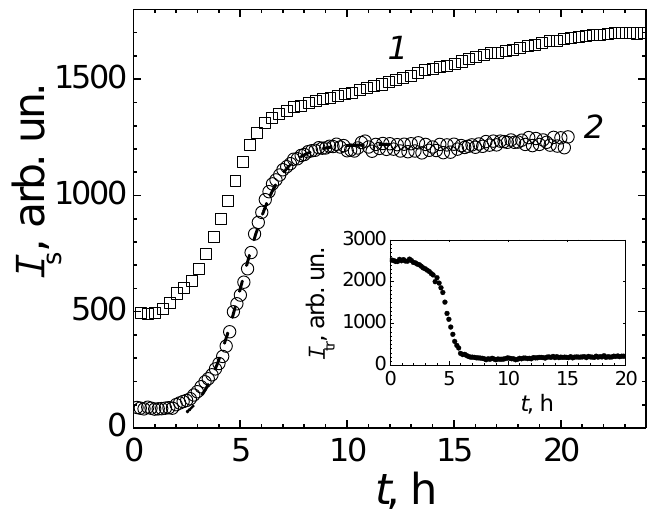
Figure 6. Dependences of the laser light scattering intensity on time for E. coli M-17 in meat-peptone broth. 1 — sample No. 3 isolated from the air intake in sealed vial; 2 — sample No. 4 with unlimited supply of air in an open vial. Dashed line is the data fit to the Verhulst formula. Insert: The intensity of light transmitted through sample with unlimited airflow as a function of time.